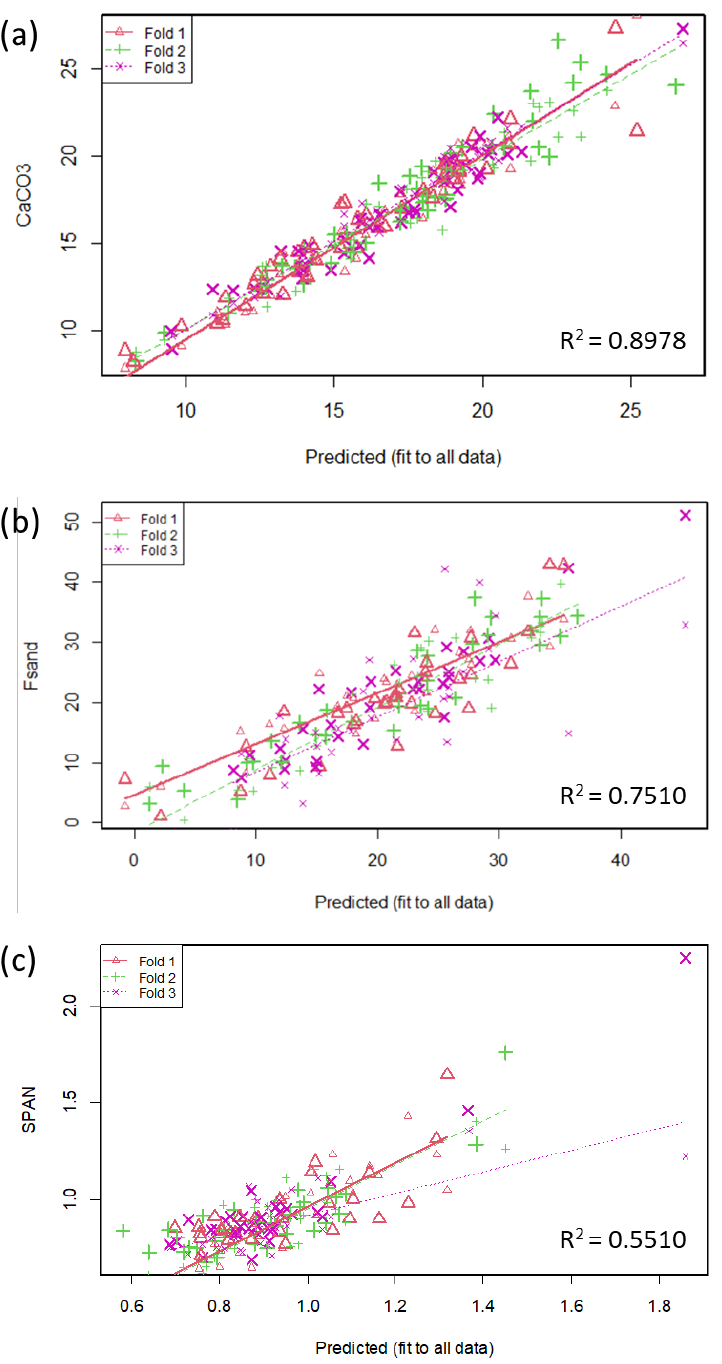
Figure 8. Cross validation results of ( a ) CaCO 3 values, ( b ) fine sand and ( c ) span . Vertical axes are measured values. Small symbols show cross-validation prediction values.